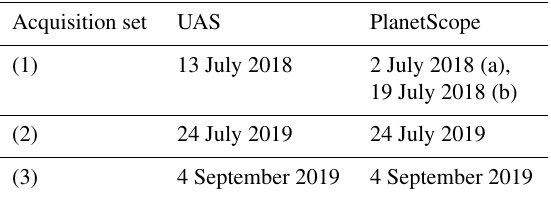
Table 3. Acquisition dates of UAS and PlanetScope images, in chronological